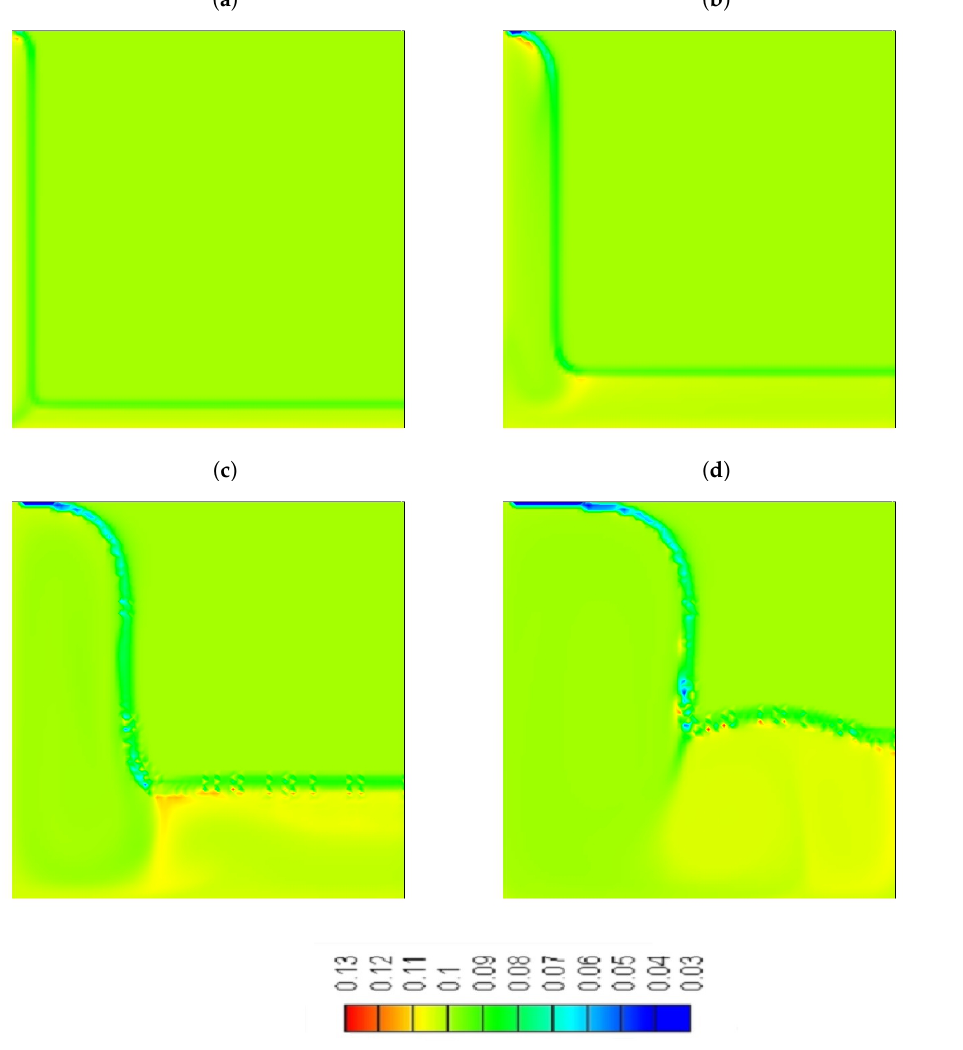
Figure 7. The evolution of concentration profiles for the case of φ w = 10%. ( a ) t = 1 s, ( b ) t = 6 s, ( c ) t = 25 s, ( d ) t = 50